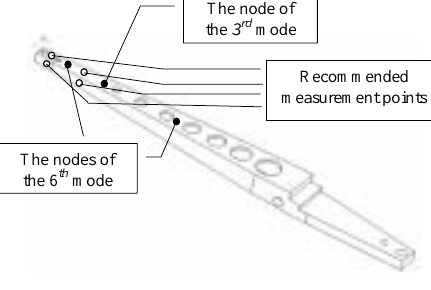
Fig. 22. Measurement points on the bond